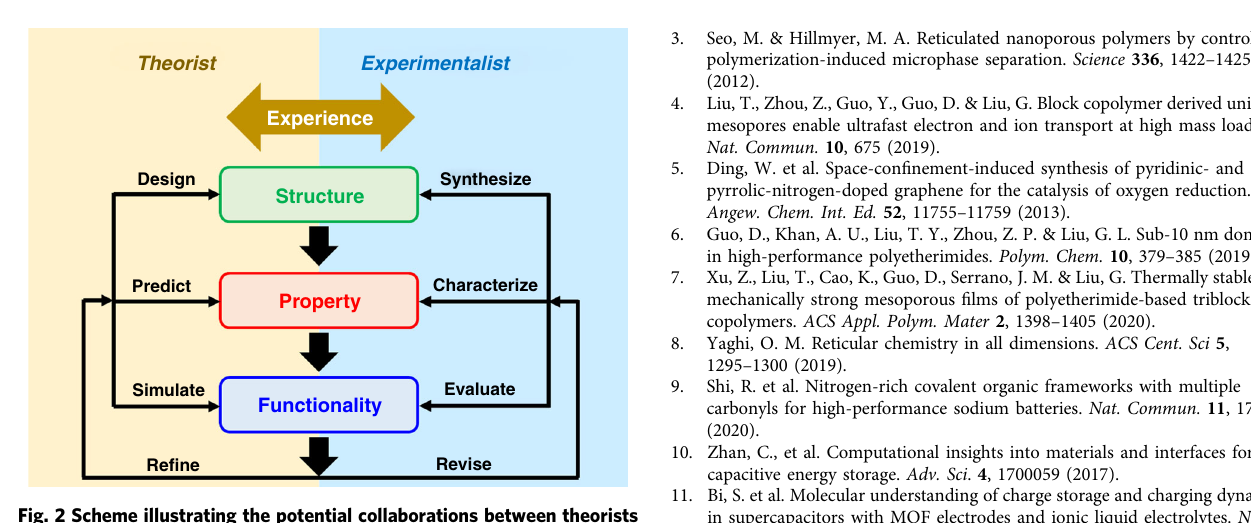
Fig. 2 Scheme illustrating the potential collaborations between theorists and experimentalists. Theorists design the structures, predict the properties, and simulate the functionalities of porous organic materials, which can be re fi ned with input from experimentalists. Exprimentalists synthesize molecules with tailored structures, characterize the properties, and evaluate the functionalities of porous organic materials, with the input from theorists to revise the experimental protocols. The ef fi cient information and experience exchanges between theorists and experimentalists will expedite the development of porous organic